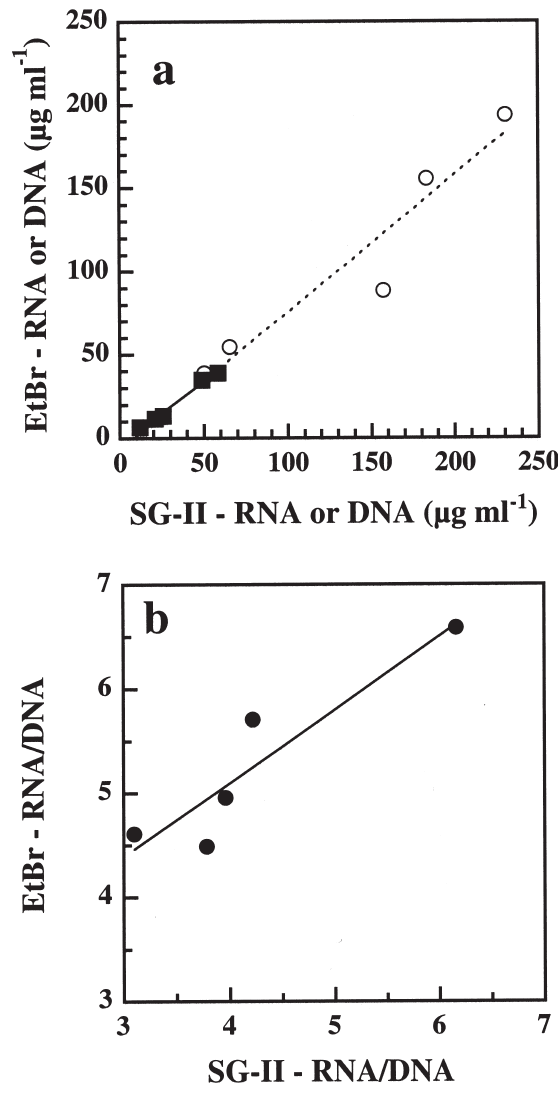
F IG . 7. – Comparison of the RNA and DNA measurements made with EtBr (y-axis) and SG-II (x-axis) in 5 individual larvae of Engraulis encrasicolus . Details in sections E and J. (a) RNA (open circles, dotted line) and DNA (filled squares, continuous line) con- centrations (µg per ml of extract); (b) the corresponding RNA/DNA (unitless) ratios. Details in sections E and J. For the RNA concen- trations the regression line is: y = -5.9861 + 0.81862x, r = 0.95747, p<0.01; for the DNA concentration it is: y = -3.3693 + 0.74353x, r = 0.99332, p<0.01; and for the RNA/DNA ratios it is: y = 2.277 + 0.70571x, r = 0.92426,